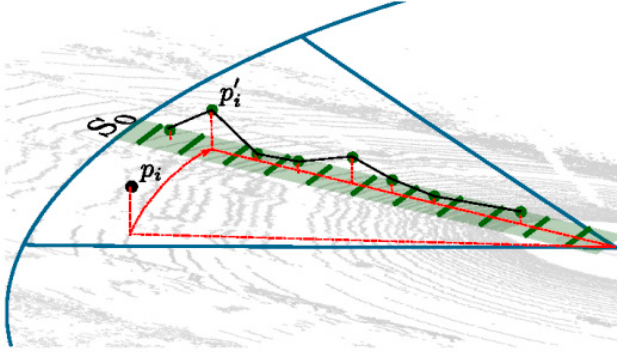
Figure 5. Mapping of 3D point p to a bin of the corresponding segment and resulting mapped point p (cid:48)